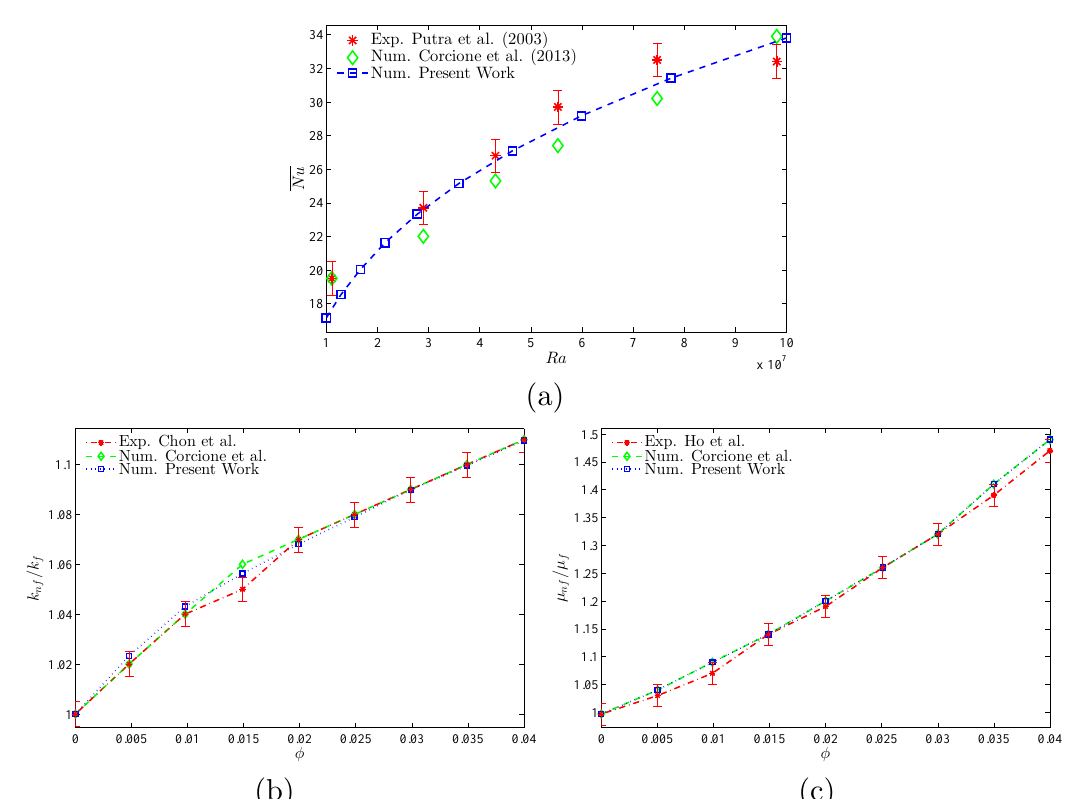
Figure 4. Validations of ( a ) average Nusselt number of the current numerical work with the experimental outcomes of Putra et al. [38] and the numerical outcomes of Corcione et al. [37] for various Rayleigh numbers at φ = 0.01 and N = 0, ( b ) thermal conductivity ratio with experimental outcomes of Chon et al. [39] and numerical data of Corcione et al. [37], and ( c ) dynamic viscosity ratio with experimental outcomes of Ho et al. [40] and numerical data of Corcione et al. [37].